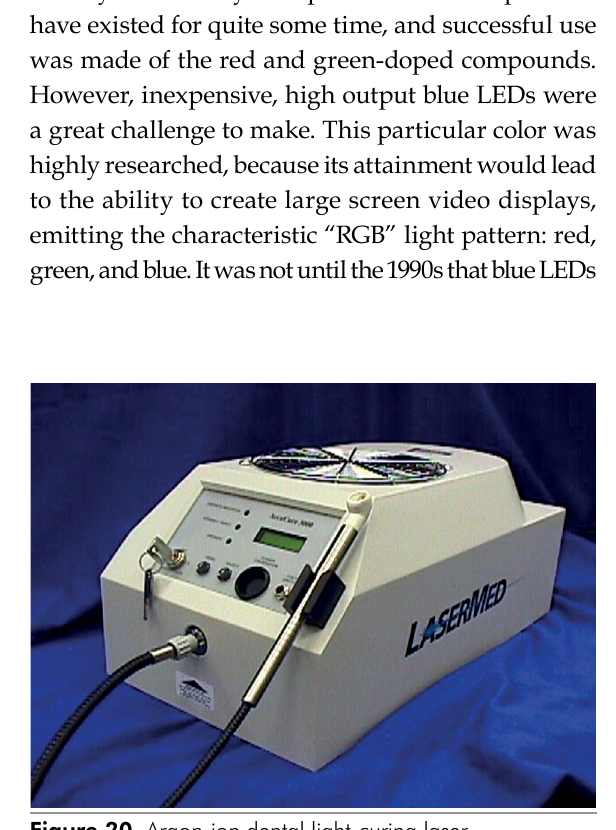
Figure 20. Argon-ion dental light-curing laser.